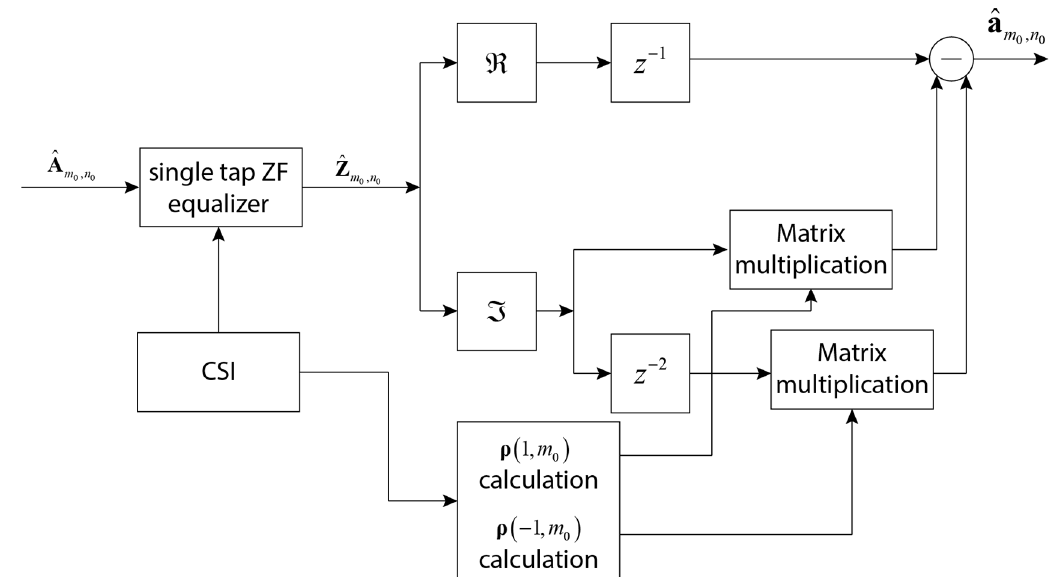
Figure 5. FBMC-OQAM MIMO ERIP equalizer block scheme.